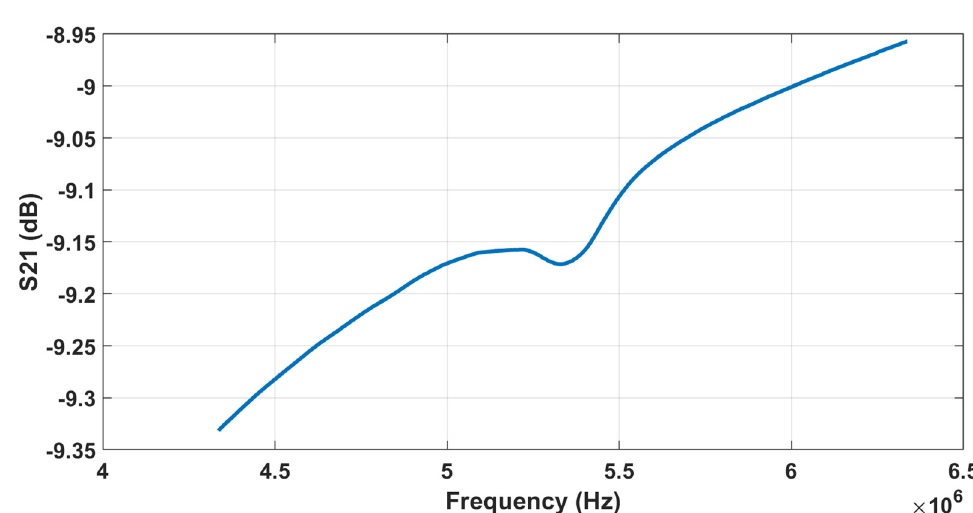
Figure 13. The measured resonance frequency of the CMUT when coated with Parylene-C.